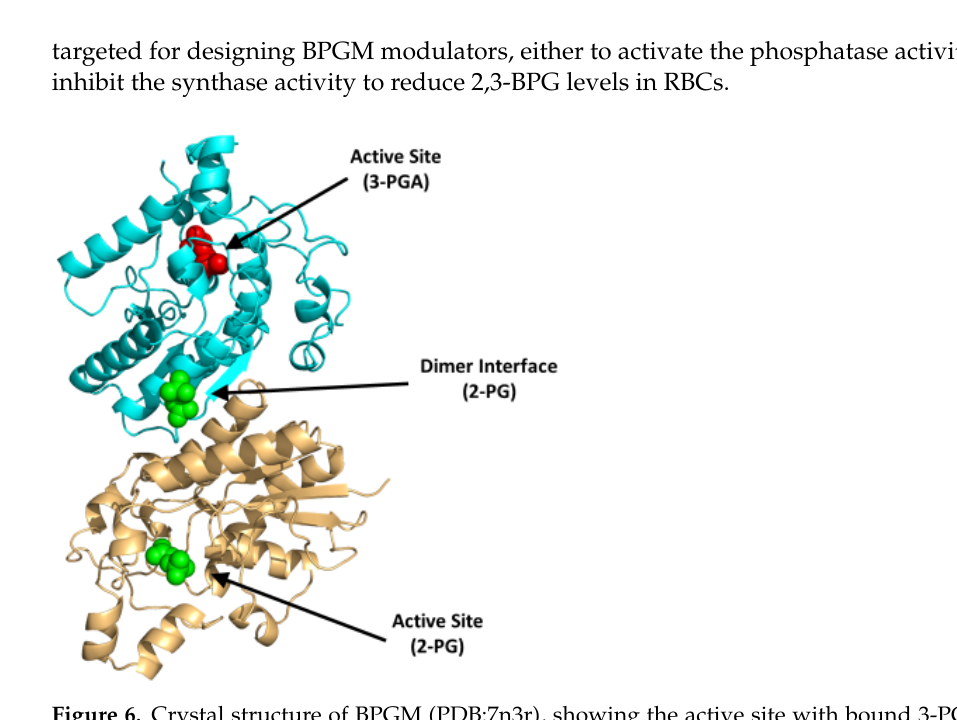
Figure 6. Crystal structure of BPGM (PDB:7n3r), showing the active site with bound 3-PGA (red sphere) or 2-PG (green sphere) and the dimer interface with bound 2-PG (green sphere). The two subunits are shown in ribbons and colored cyan and gold.